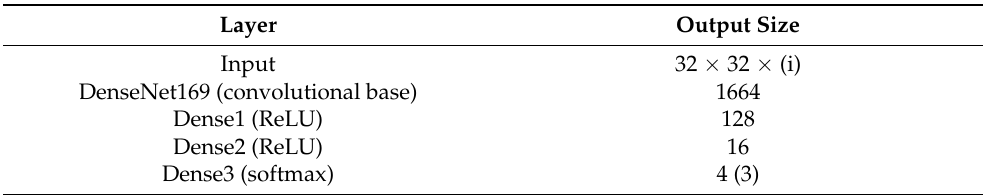
Table 3. Configuration of Dense169 CNN model. (i) is the number of input bands. We classified into 4 or 3 disturbance